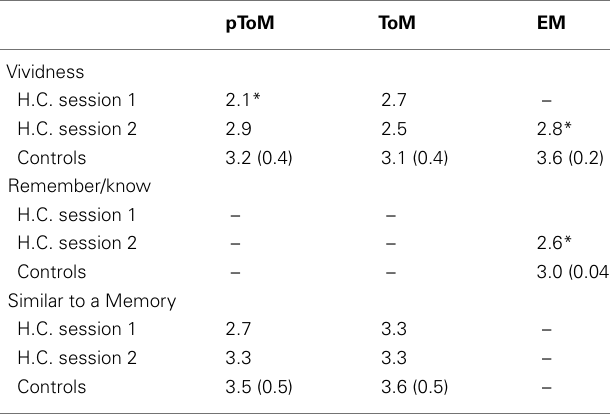
Table 2 | Phenomenological qualities of the generated pToM,ToM, and EM